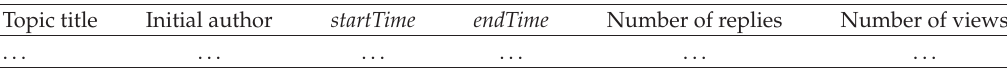
Table 2: Data format.